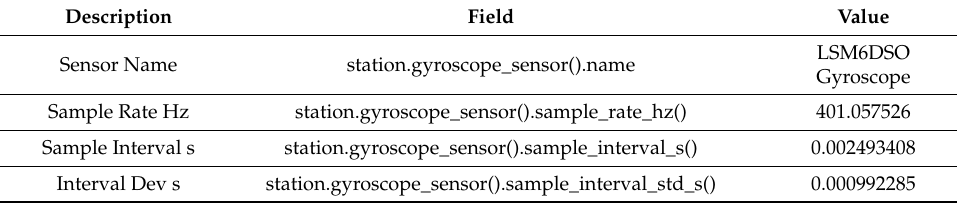
Table 8. Gyroscope Sensor.